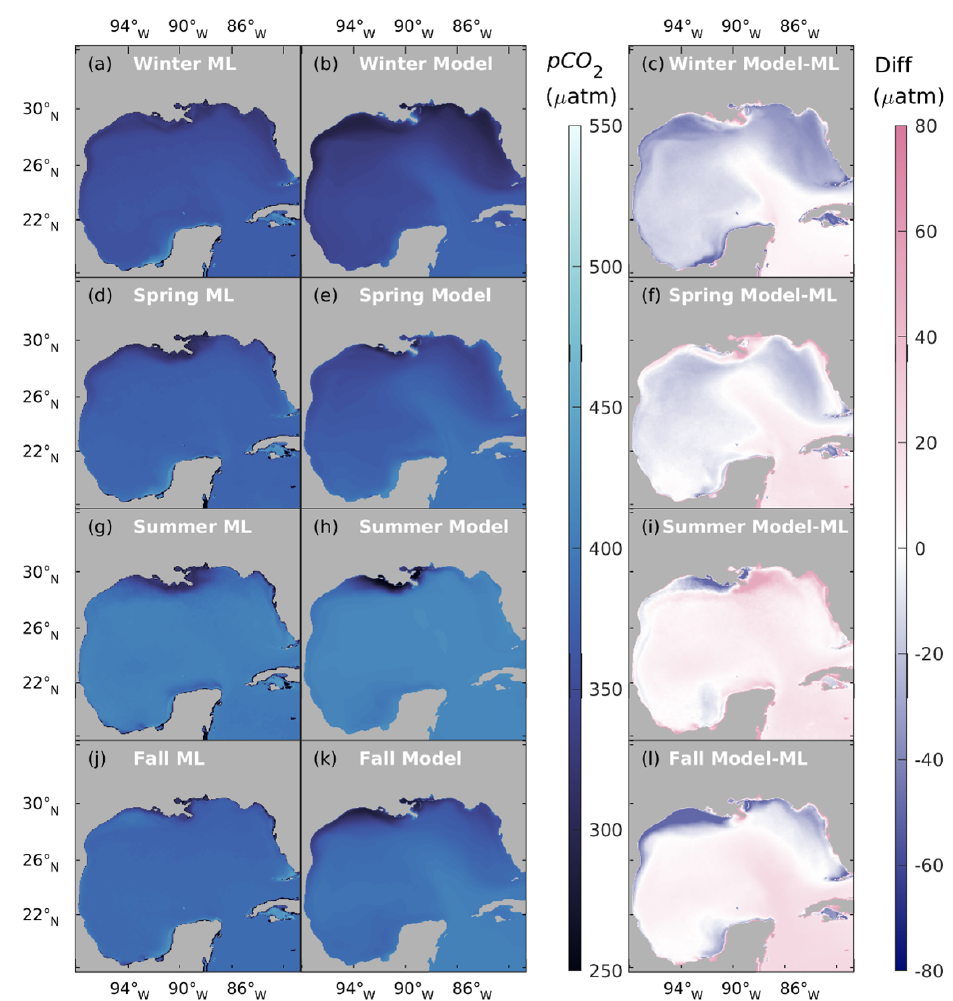
Figure 6. Comparison of surface p CO 2 between the ML model (Chen et al, 2019) and this